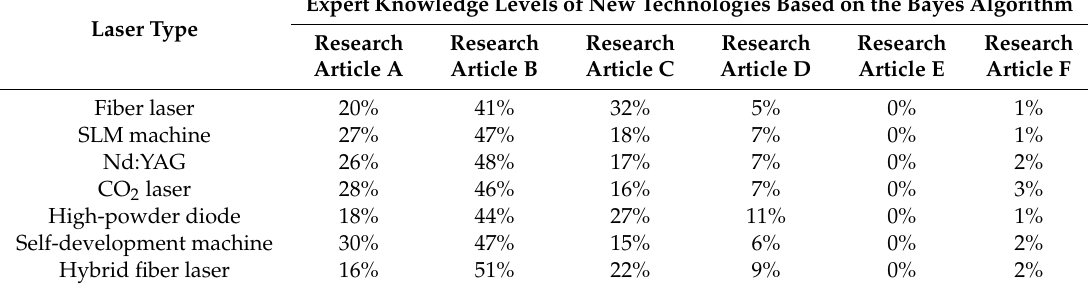
Table 3. Knowledge levels of new technologies based on the Bayes algorithm (factor: laser type). Laser